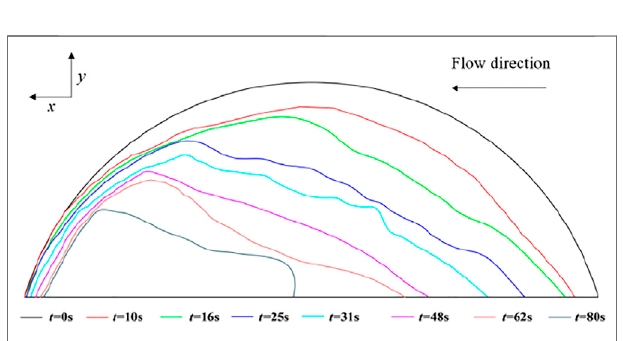
FIGURE 4 | Morphological evolution of the deposit